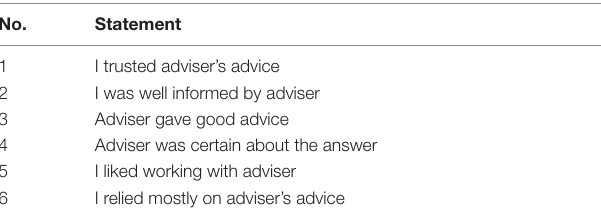
TaBle 2 | items for postexperimental assessments of the